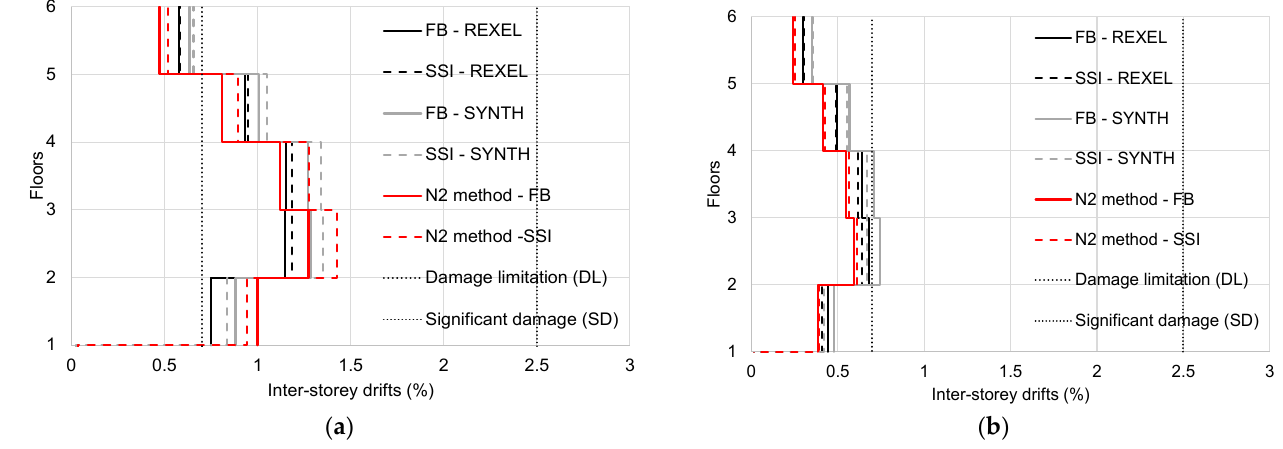
Figure 18. Comparison of inter-story drifts for: ( a ) X-direction, PGA = 0.215 g and ( b ) X-direction, PGA = 0.10 g.